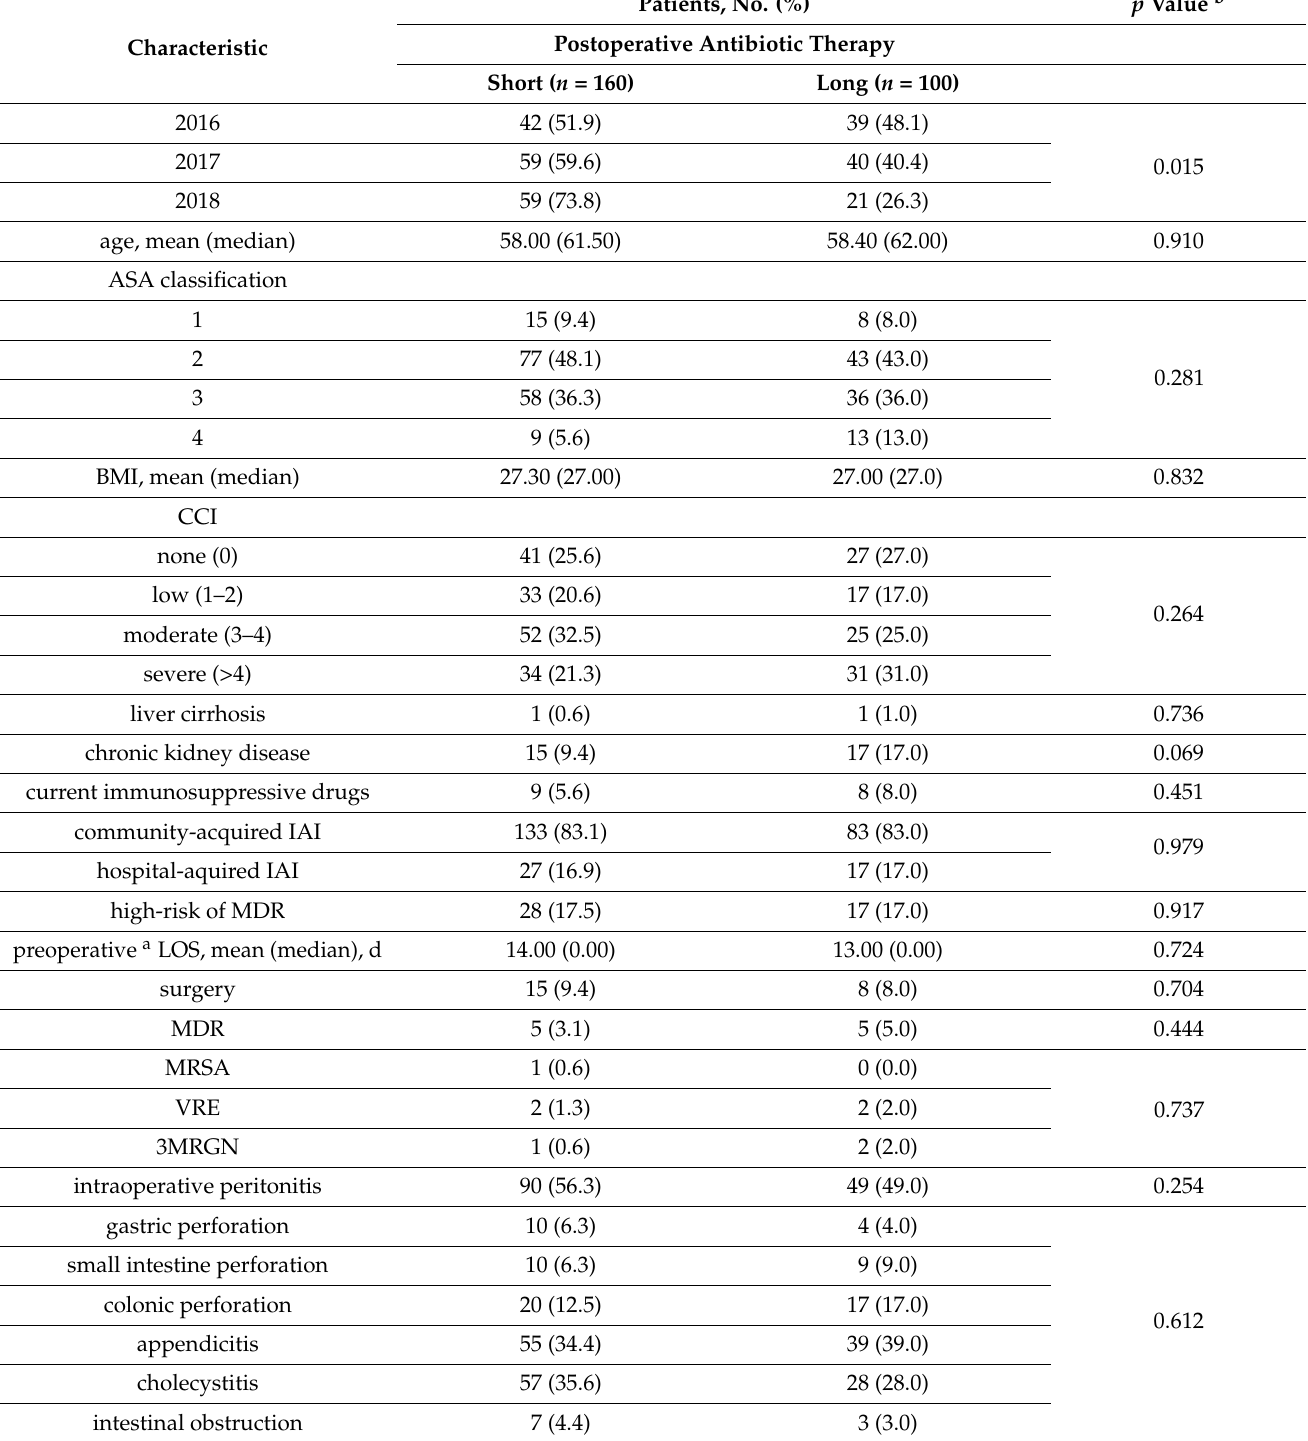
Table 1. Preoperative patient characteristics and intraoperative